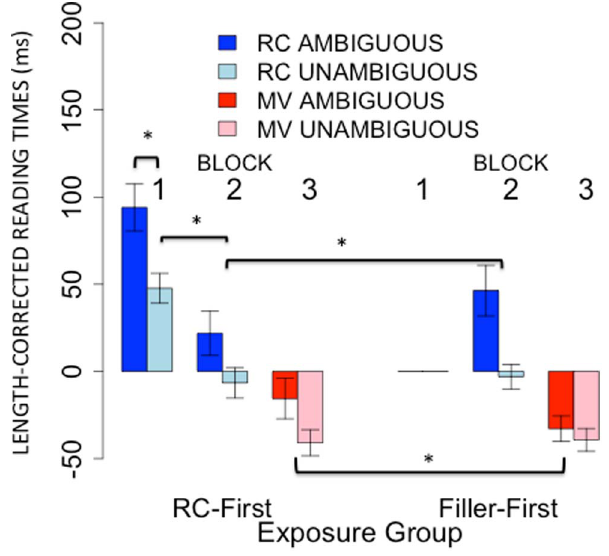
Figure 7. Results of Experiment 2. Mean length-corrected reading times in each block for the RC-First and Filler-First experimental groups. Error bars represent 95% confidence intervals on the means. Brackets with asterisks (*) indicate significant comparisons. For details, see main text.